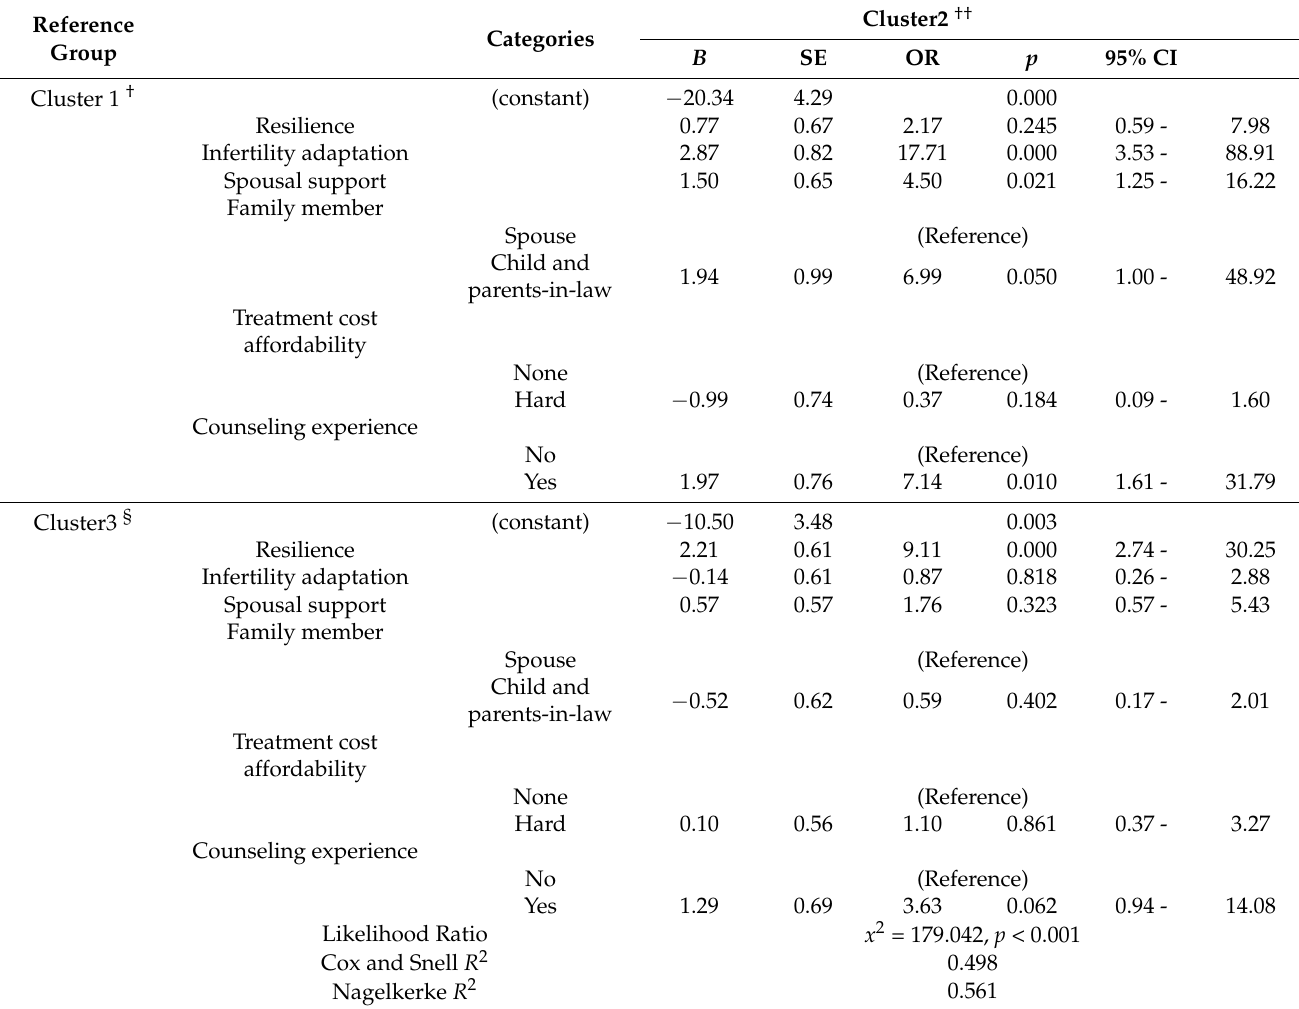
Table 5. Predicted characteristics by type of stress coping ( N =